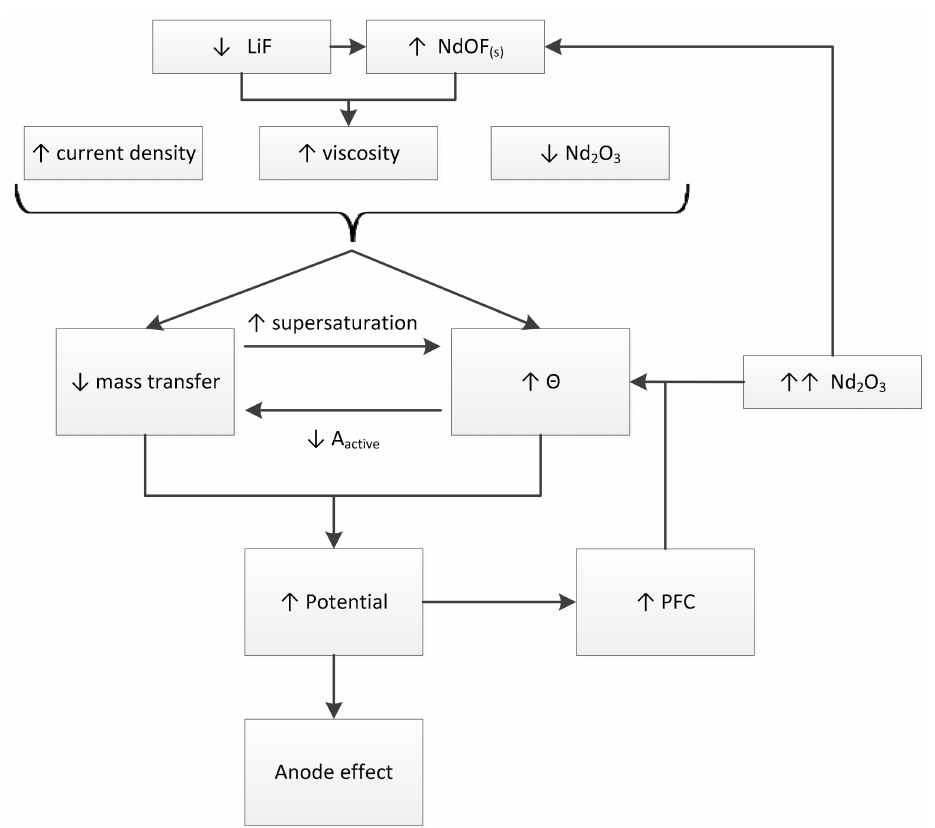
Figure 8. Schematic representation of the relation of the overall cell potential to different factors considered in this study. Arrows in the block: ↑ —increase; ↓ —decrease; ↑↑ —high feeding rate or above